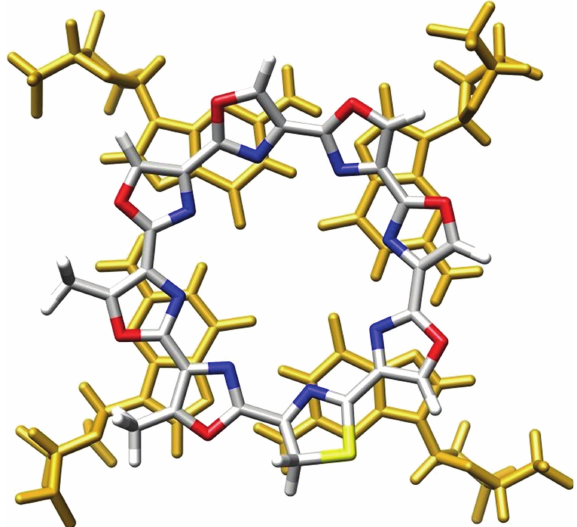
Figure 3: Qualitative in silico superposition of telomestatin and a G-tetrad (extracted from PDB entry: 2A5R); guanine residues appear in gold; the carbon, nitrogen, oxygen, sulphur, and hydrogen atoms of telomestatin appear in grey, blue, red, yellow, and white,